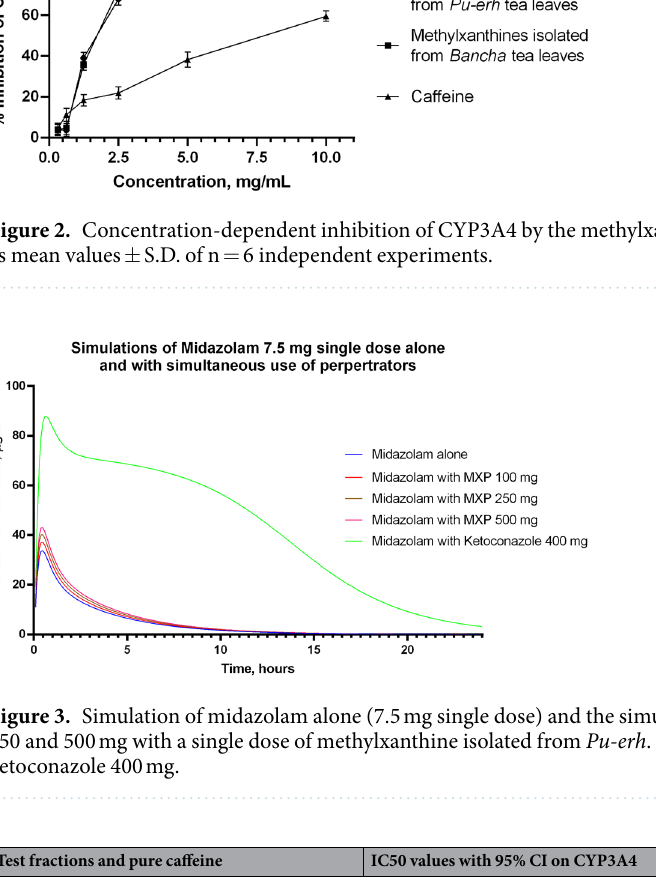
Test fractions and pure caffeine